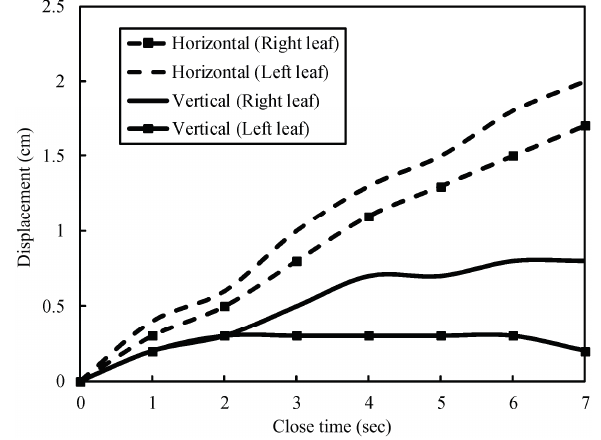
Figure 16. Single-pair leaf closing experiment curve (close time vs. displacement